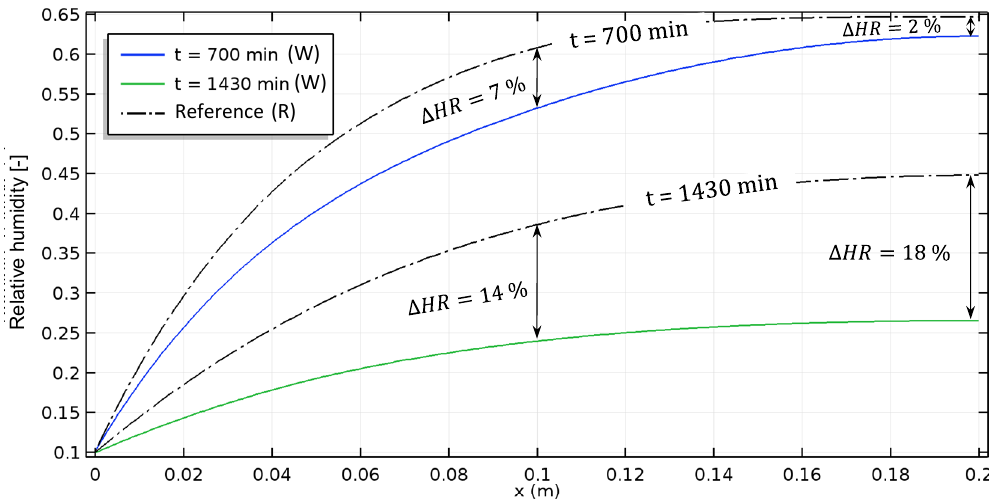
Figure 14. Non-isothermal case: Relative humidity profiles of aged and reference hemp concrete (W: Weathered; R: Reference).